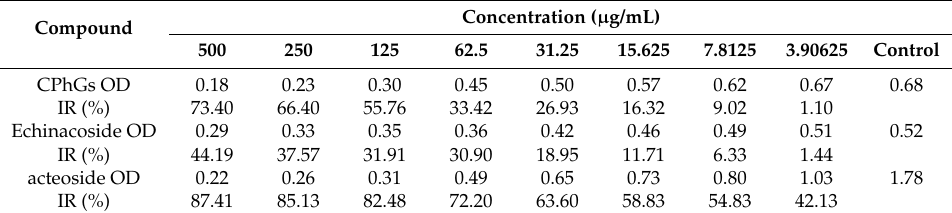
Table 1. IC 50 determination of CPhGs, echinacoside and acteoside on HSC.